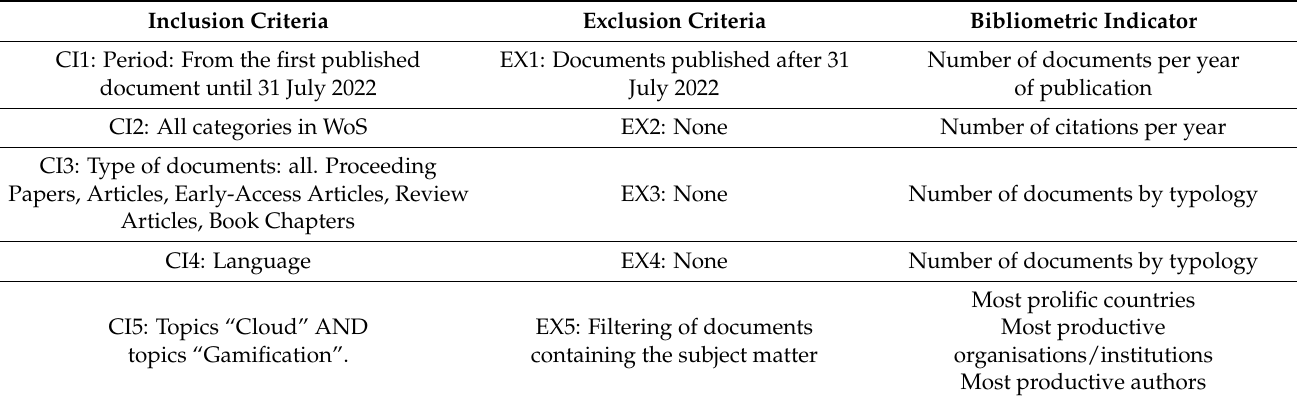
Table 1. Research